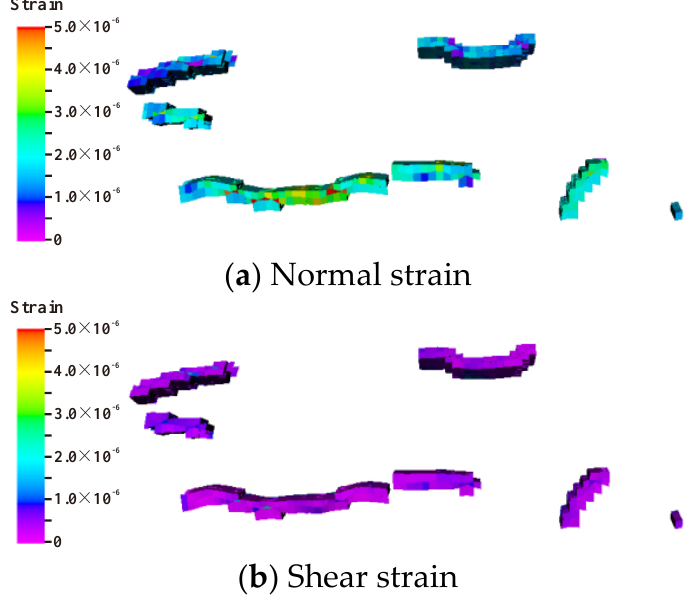
Figure 12. Elastic strain distribution of faults in the target formation.